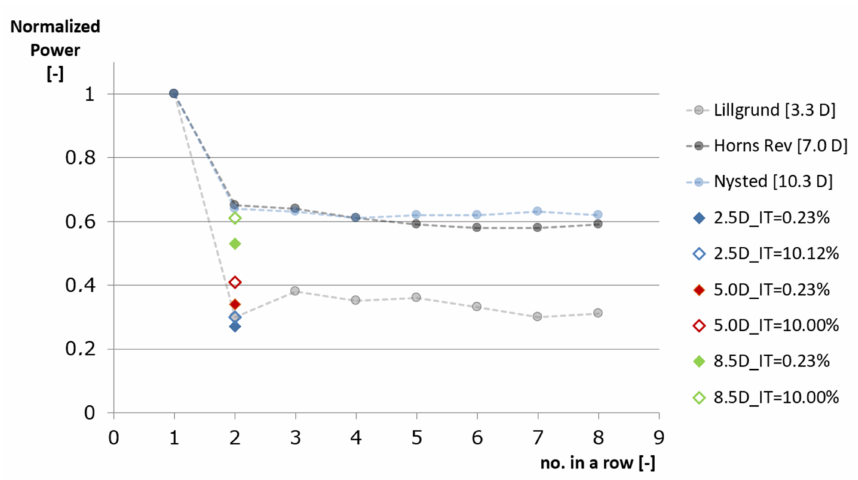
Figure 15. Comparison of normalized power of two in-line turbines with full-scale wind farm performance: Nysted [49], Lillgrund and Horns Rev [50].